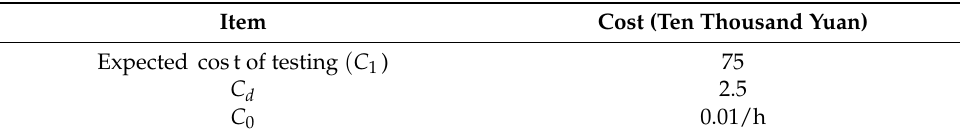
Table 12. Expected test cost and accelerated degradation test cost.